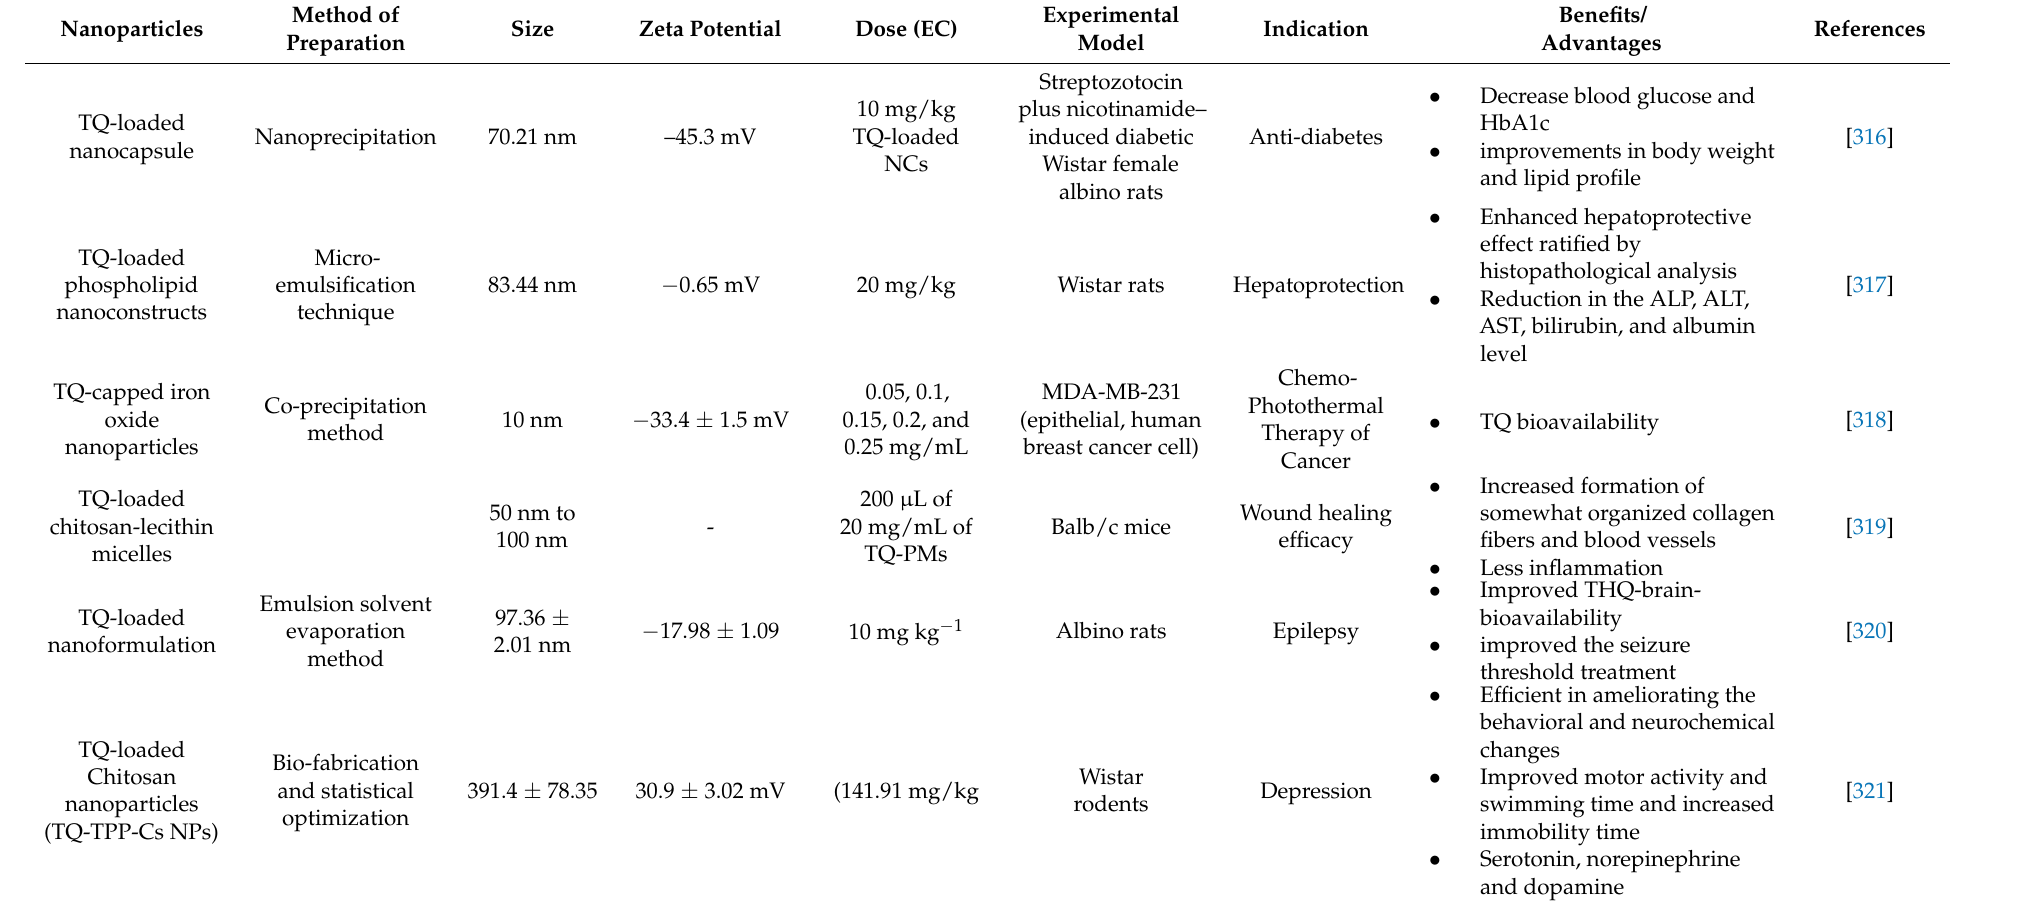
Table 13. Recent progress in nanoparticle-mediated drug delivery of